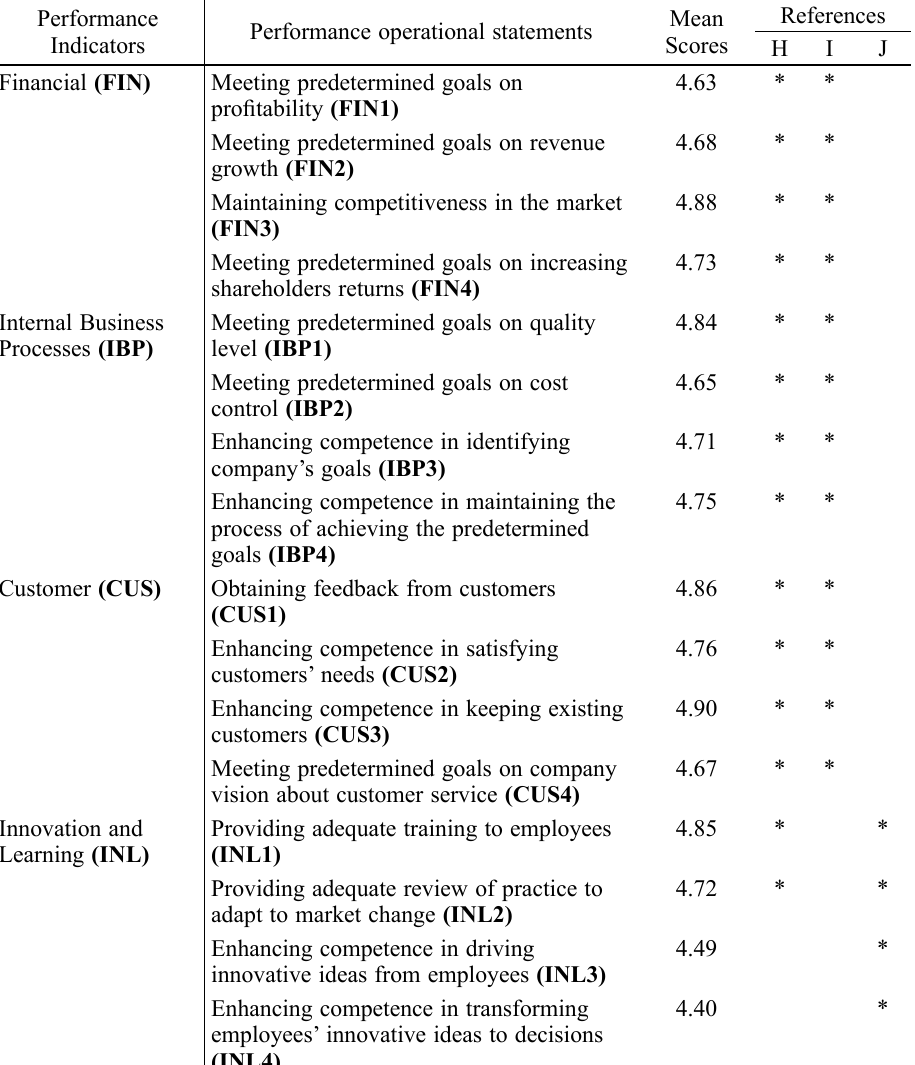
Table 2. Performance indicators of construction organizations